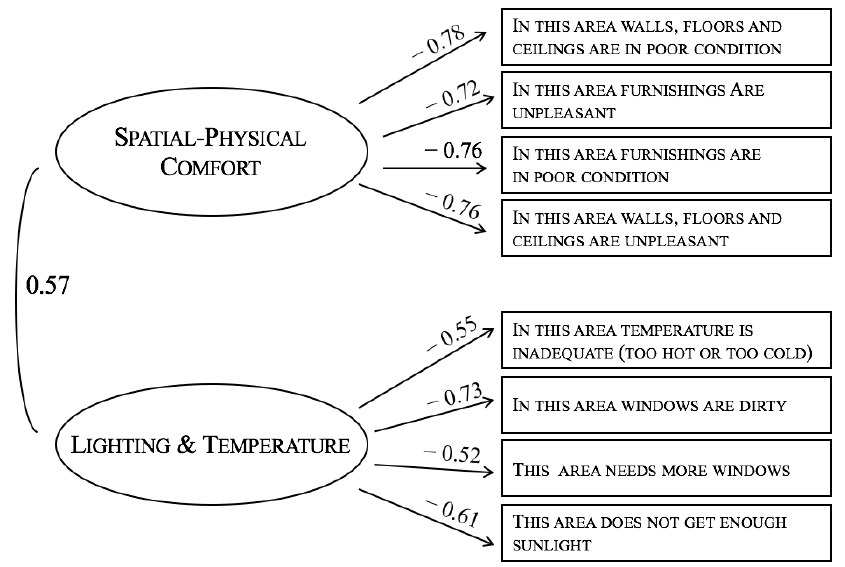
Figure 4. CFA. Interior private spaces.